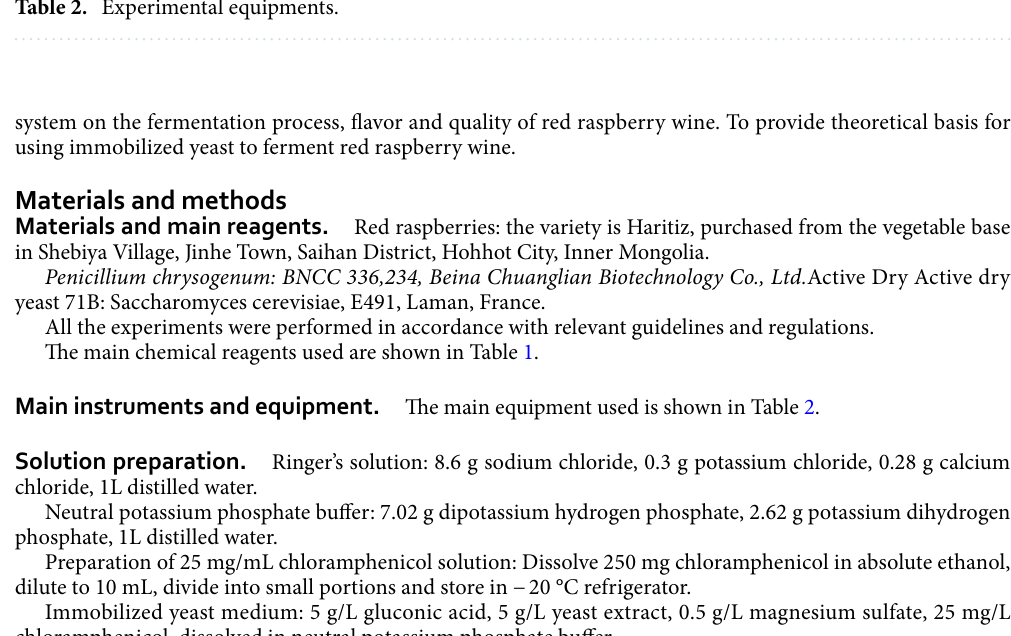
Table 2. Experimental